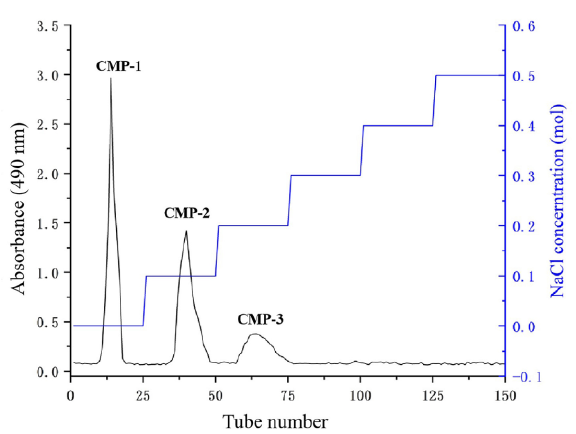
Figure 1. Elution profile of polysaccharides on DEAE-52 cellulose column.